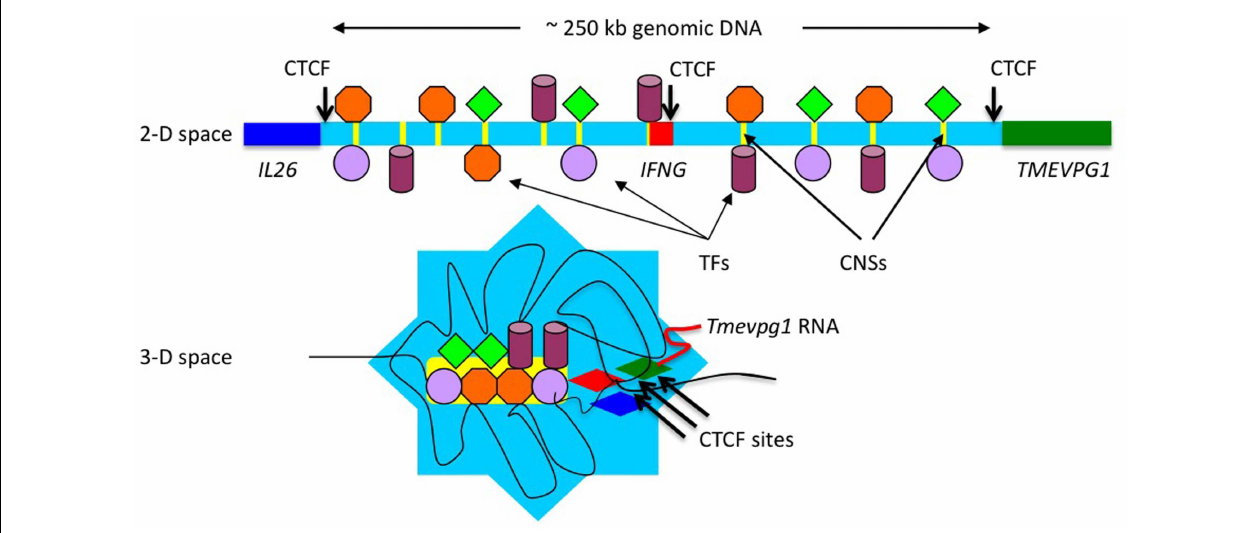
other functions to these DNA elements. Changes in three-dimensional conformation of the locus may serve to localize these DNA elements and their associated proteins to the IFNG gene. It has been argued that CTCF sites serve as boundary elements to insulate IFNG . An alternative hypothesis is that CTCF sites serve to bring IL26 close to IFNG to allow it to share the same transcriptional enhancers and to bring TMEVPG1 close to IFNG to allow TMEVPG1 RNA to associate with the IFNG